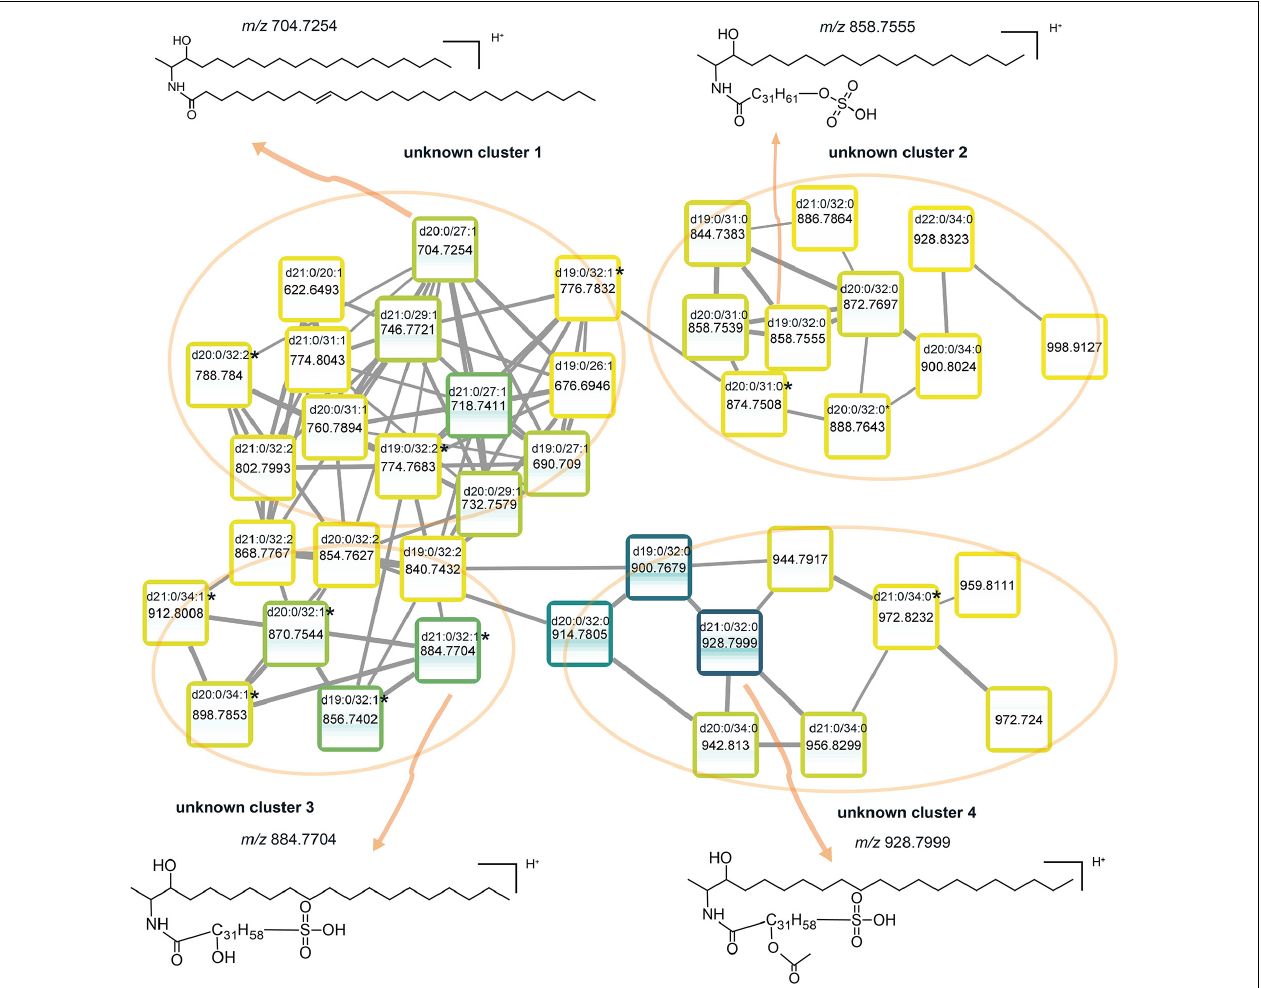
FIGURE 6 | Molecular subnetwork of sphingolipids1. Boxes shown in subnetwork are the same as nodes shown in Figure 2 , representing lipid species. The outlines of the boxes are labeled from light yellow to dark blue with the increasing of the summed intensity among all the water column samples (15 depths). Inside the box, a heatmap represents the distribution of this lipid species across the water column, from top (50 mbsl) to bottom (2,000 mbsl). ∗ Represents there is a –OH group in the fatty acid chain of the lipid. Mass spectra of novel lipids are shown in Supplementary Figures 3A–D